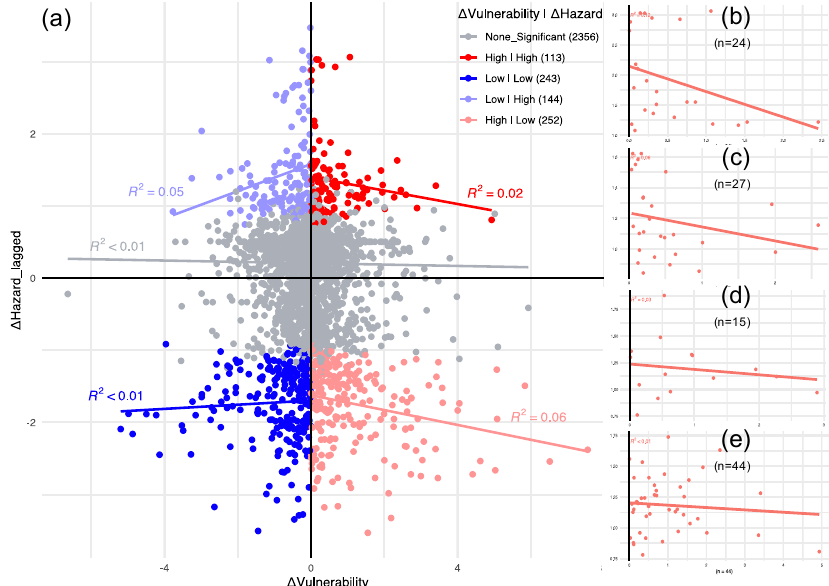
Figure 7. Moran’s I scatterplot of changes in total risk. ( a ) All counties, ( b – d ) regional subgroups of counties in the High|High (increased risk) category with ( b ) California, ( c ) Southeast, ( d ) Central, and ( e ) Northwest.